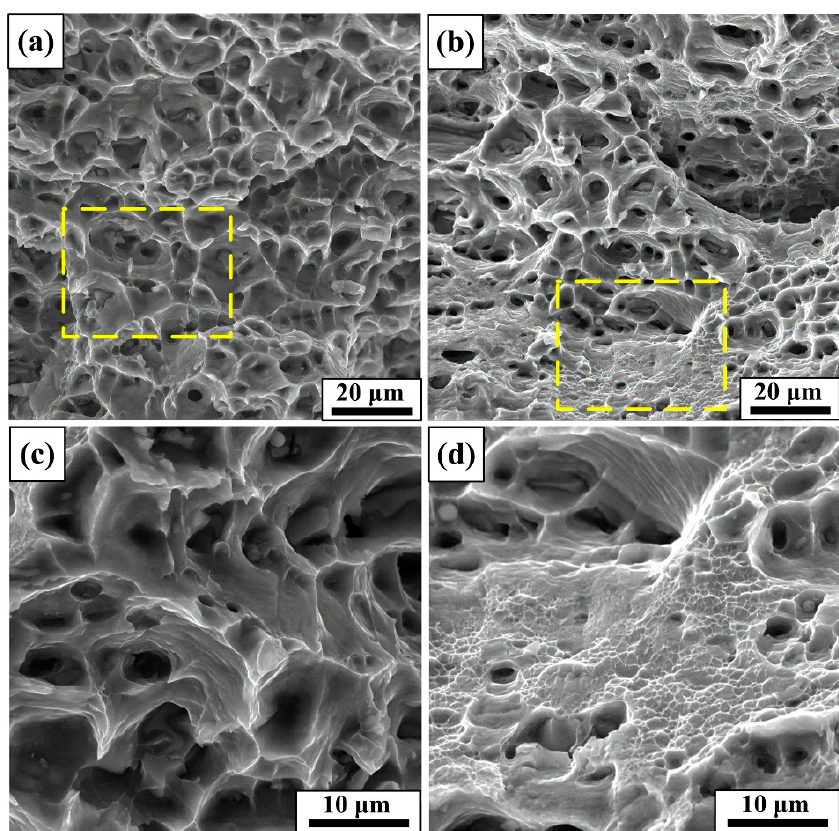
Figure 13. SEM observation showing the fracture morphologies in different states: ( a , c ) T6, ( b , d ) S + EA.